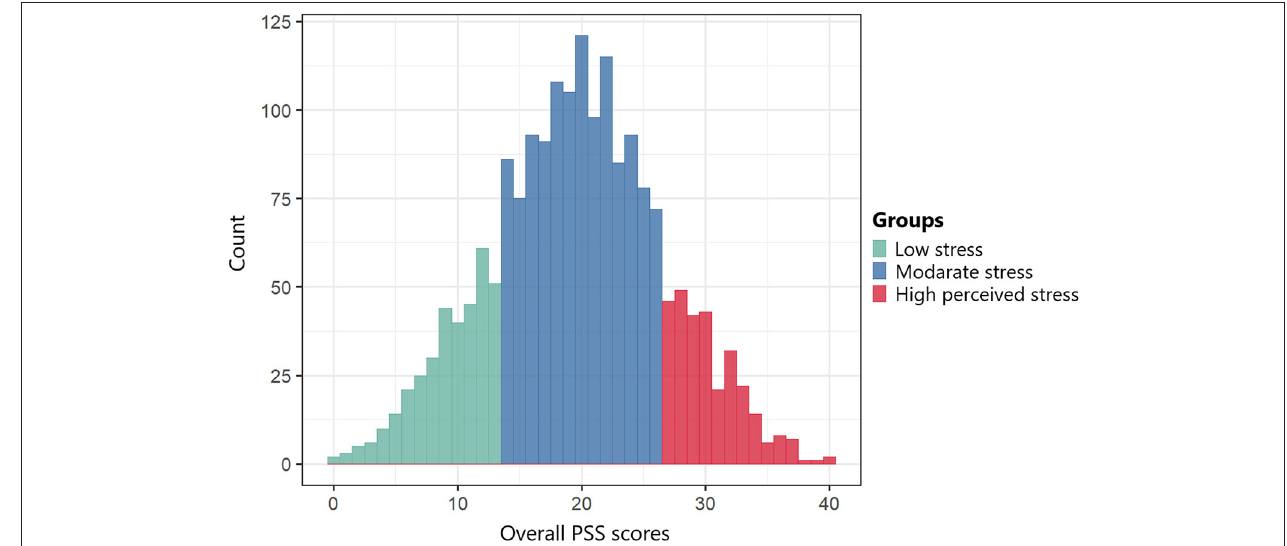
FIGURE 1 | Distribution of study participants by the overall PSS